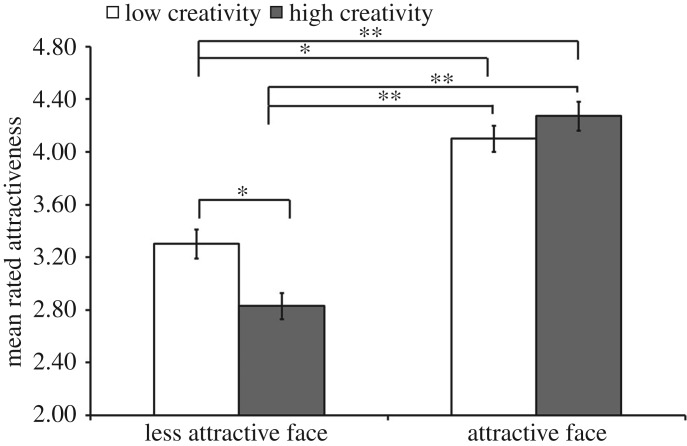
The significant two-way interaction between facial attractiveness and creativity in judgements of women's attractiveness (ηp2 = 0.20). Asterisks indicate medium (*) and large effect sizes (**) using Cohen's d.